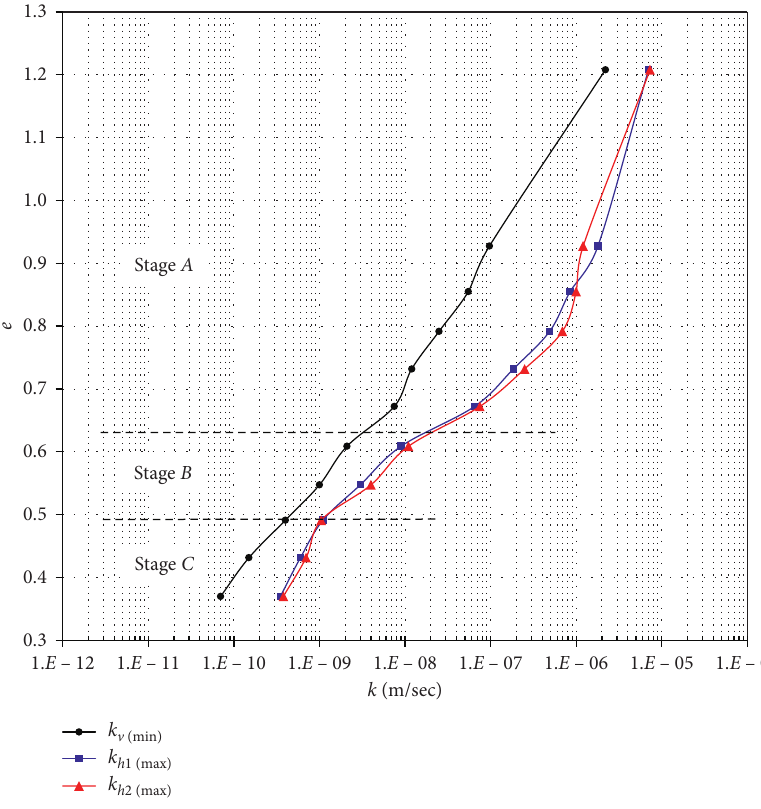
Figure 4: The k ( e ) graph for sample Ι